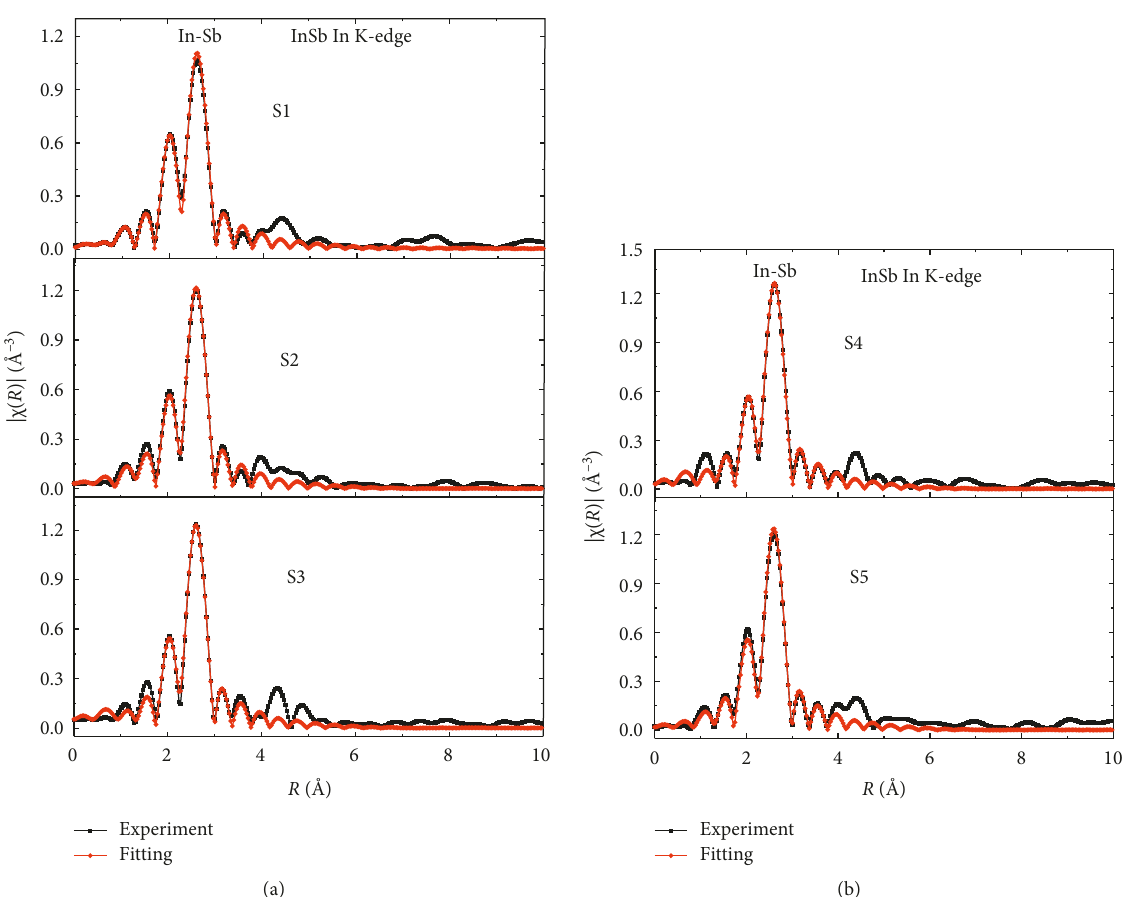
Figure 5: The magnitude of the Fourier transforms of measured samples (black lines) and the results of fitting (red